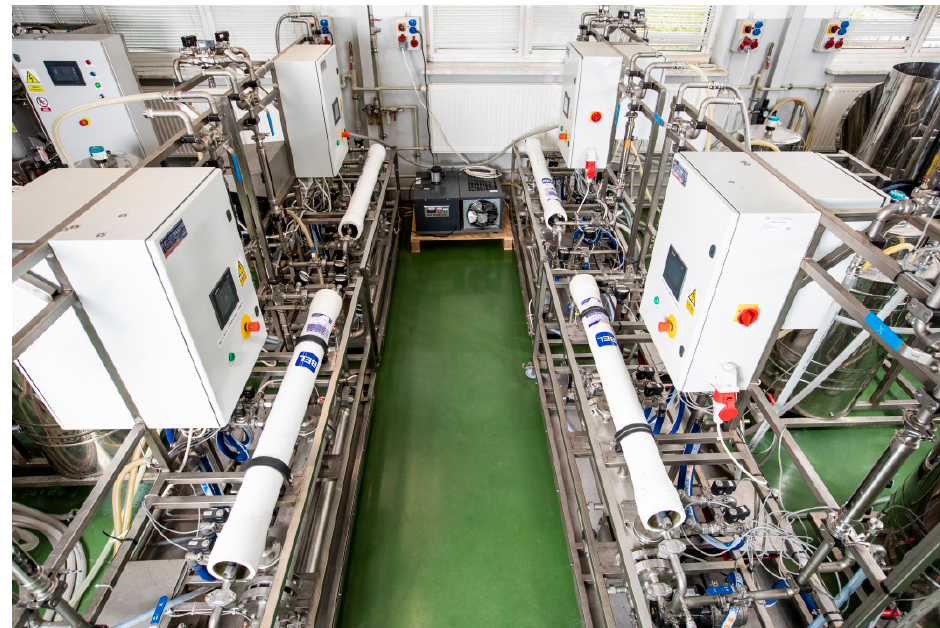
Figure 1. Integrated membrane system for industrial wastewater treatment.